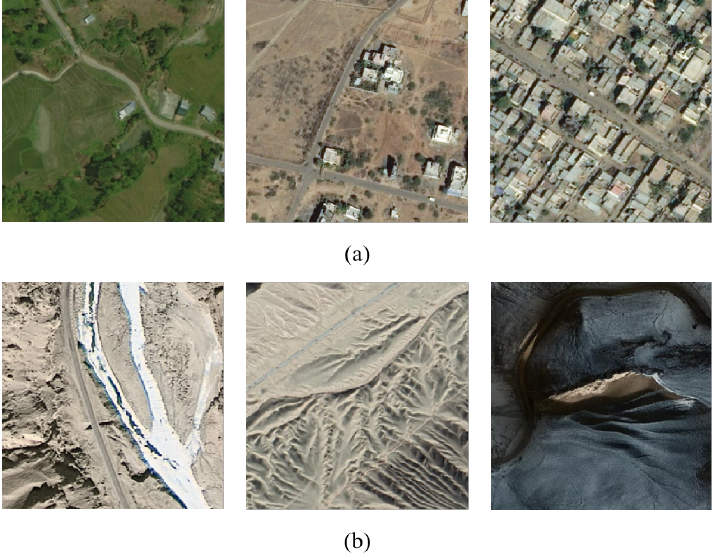
Figure 2. Roads in DeepGlobe are easier to identify in ( a ), while roads in ( b ) from RDCME are challenging to extract because they are similar in shape to other